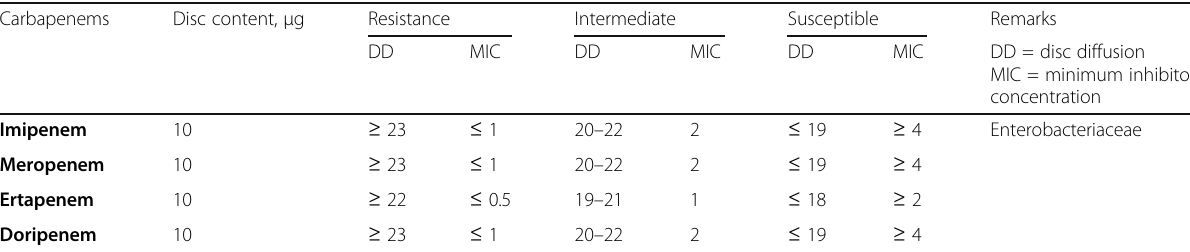
a Isolates were pulled together from both interlinked matrices Table 3 CLSI interpretive standards for carbapenems (CLSI M100-2017)